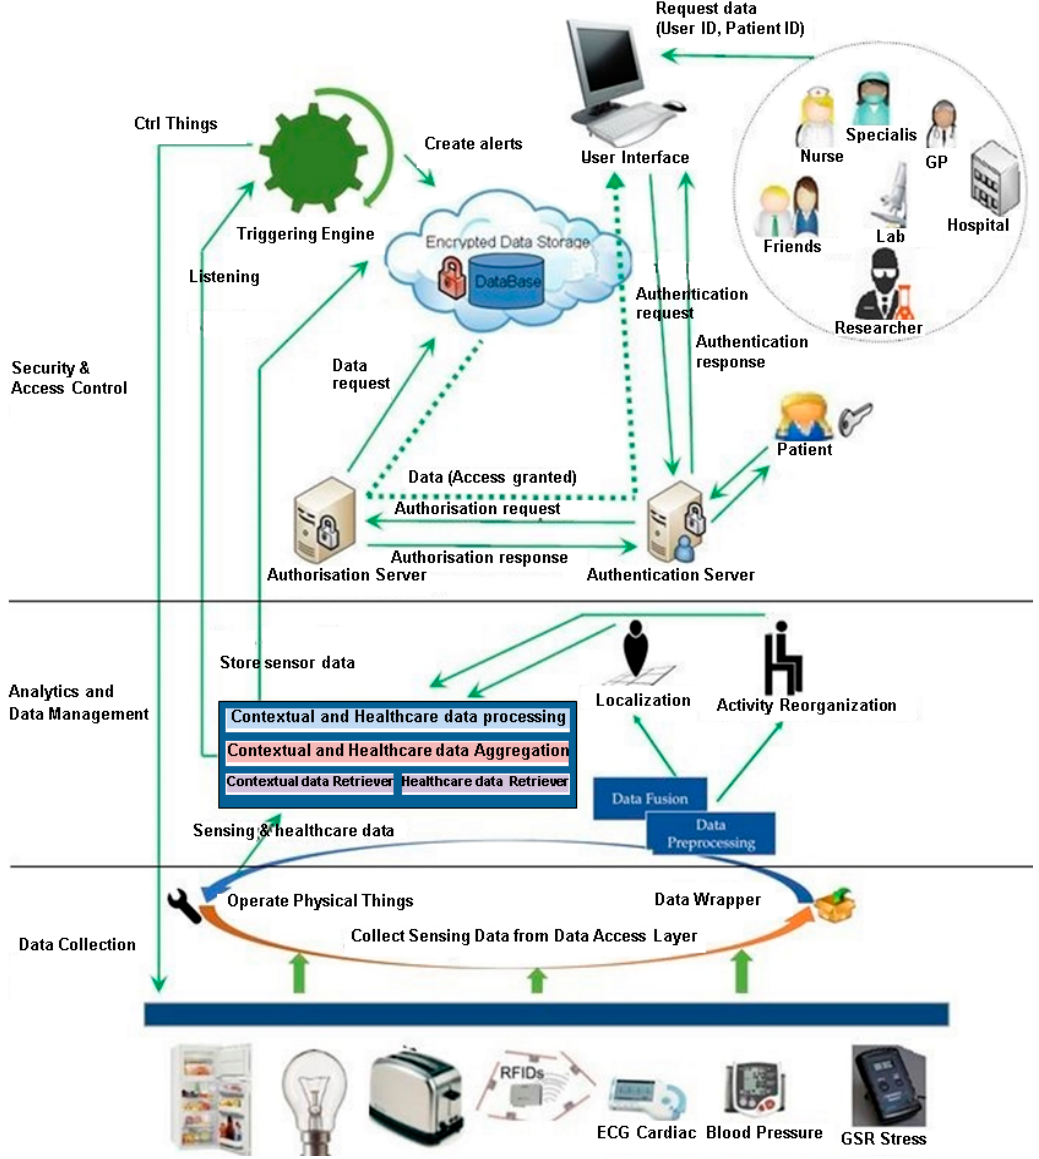
Figure 2. Framework of Proposed Architecture.